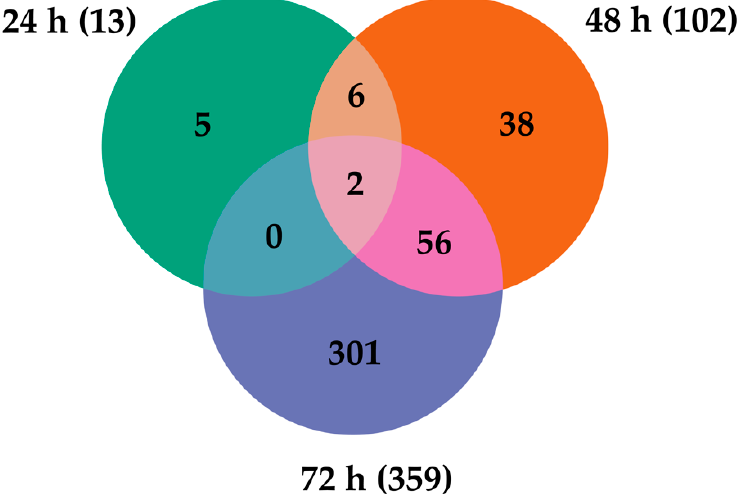
Figure 2. Venn diagram representing the number of differentially expressed transcripts at the different time points post-infection with LamV.